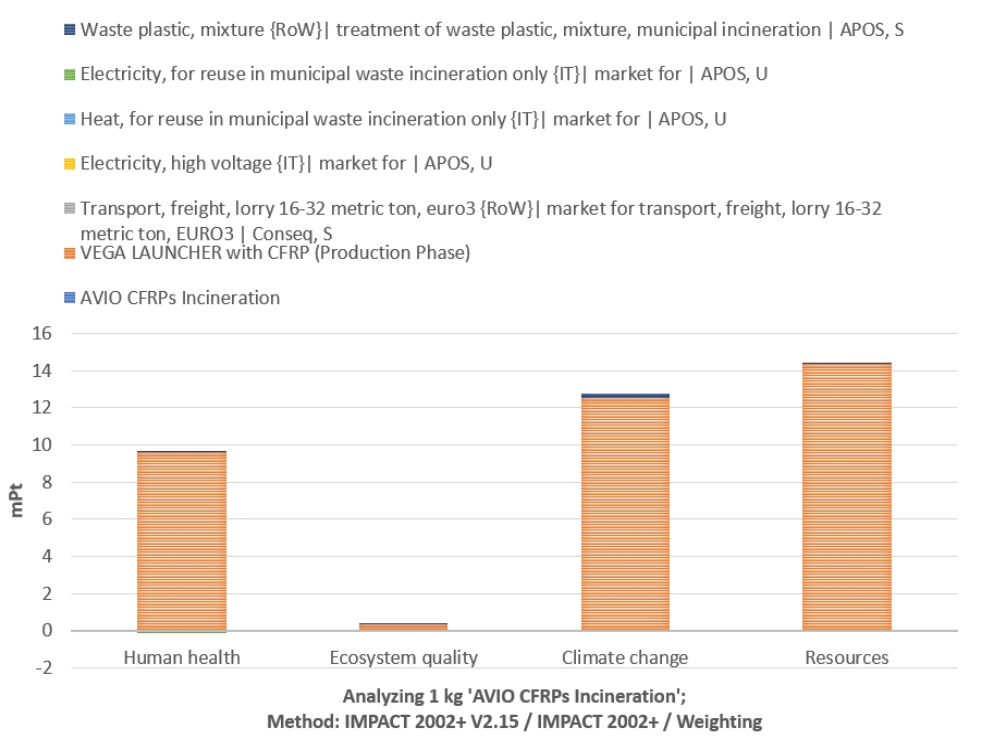
Figure 12. Results of Incineration into Endpoint categories.